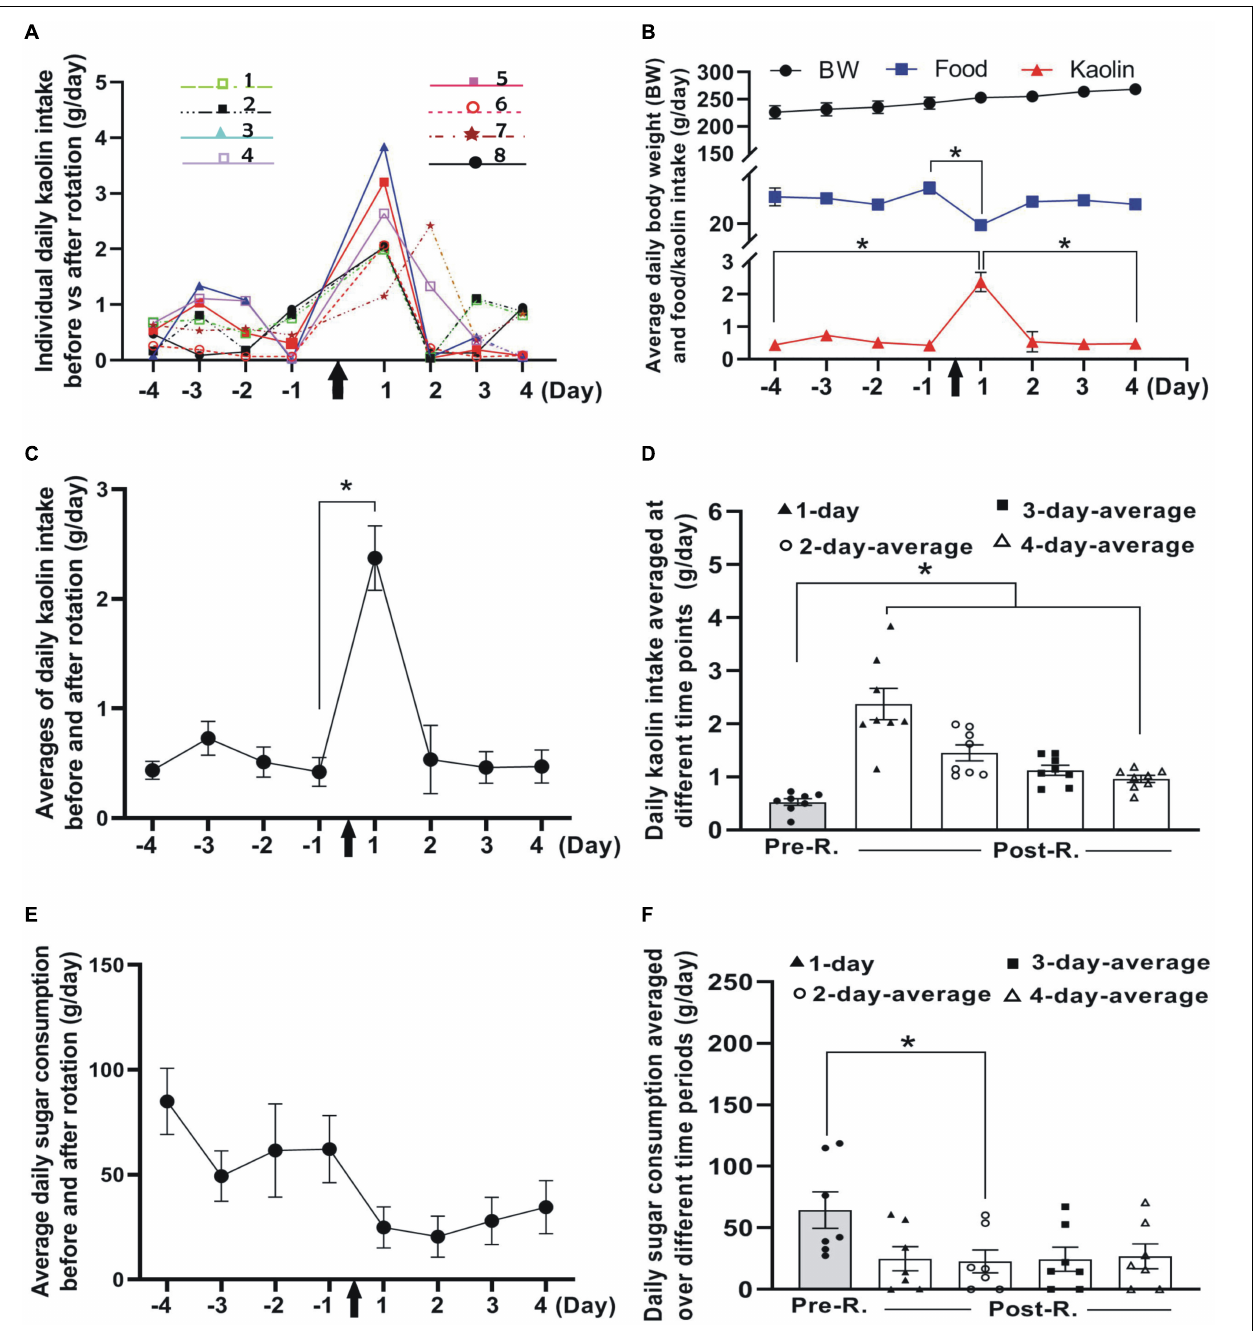
FIGURE 2 | Impacts of double-axis rotation on pica and CTA in animals of pilot group ( n = 8). (A) Line plot depicting the profile of daily kaolin intake (KI) (measured on 24-h basis) at different time points before and after rotation. The different colored lines and symbols represent individuals numbered for the experiment (insets). (B) Body weight (BW, top), food consumption (middle), and kaolin intake (lower) plotted against time points (day) before and after rotation. Note the significant decrease in food consumption at day 1 following the rotation exposure ( *p < 0.05, Wilcoxon paired-test). (C) Mean of daily KI before and after rotation across individuals, the same data also shown in panel (A) ( *p < 0.05, Wilcoxon paired-test). (D) Daily KI averaged over different duration in Phase 3 as compared with mean of baseline (Phase 1). Daily KI averaged at day 1 and over the first 2, 3 or, 4 days following the rotation are significantly higher than baseline ( *p < 0.05, ANOVA post-hoc test). (E) Profile of daily sugar consumption at different days before and after rotation ( n = 7). (F) Daily sugar consumption averaged over different time periods in Phase 3 as compared with mean of baseline (Phase 1) ( *p < 0.05, n = 7; non-parametric Fridmann followed by Dunn’s test). KI, kaolin intake; Pre-R, pre-rotation; Post-R, post rotation. Black arrows indicate the time when animals were